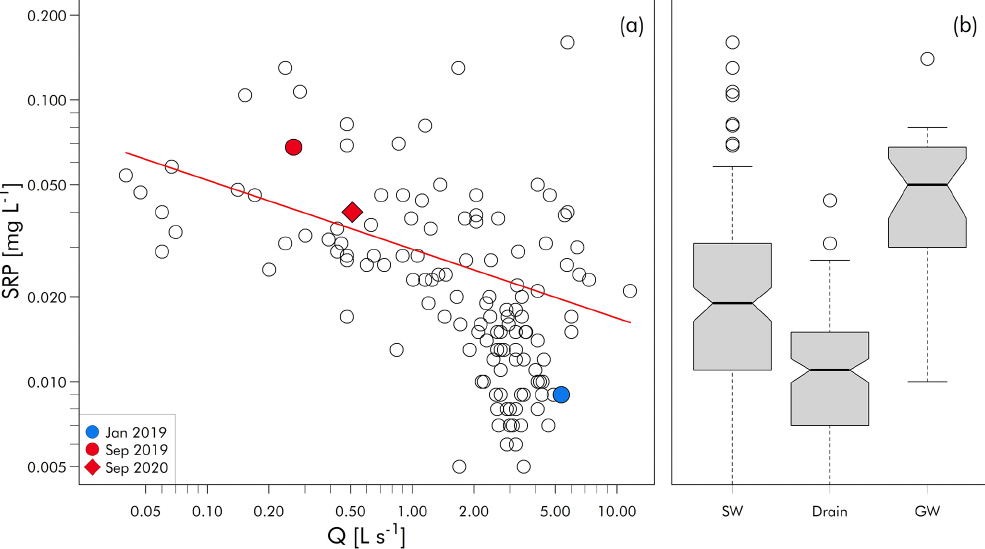
water concentrations observed in the same range.